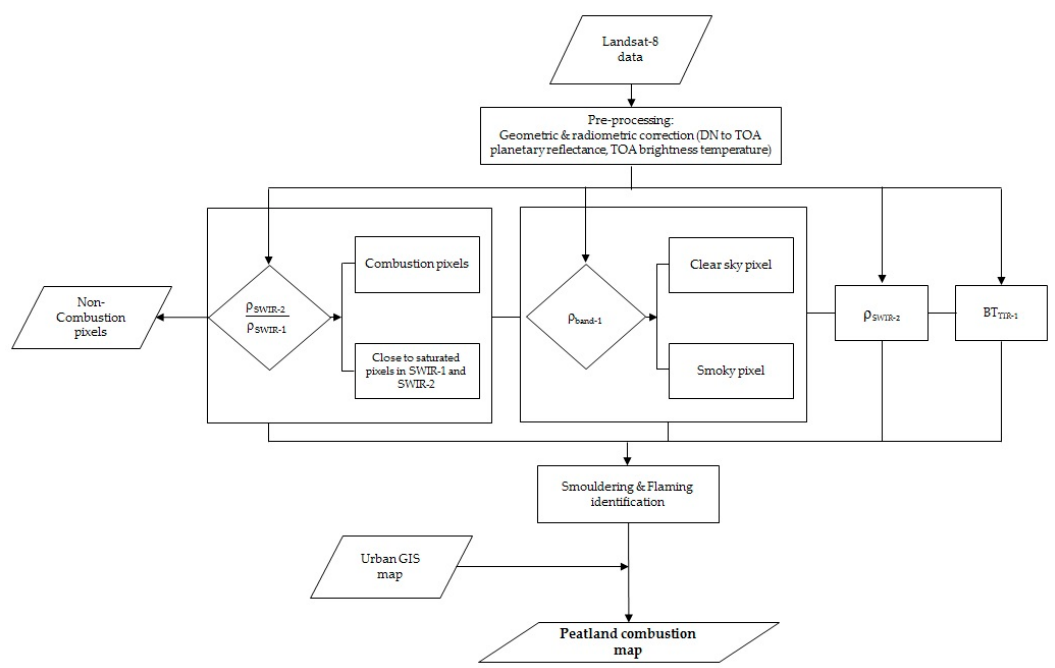
Figure 4. Flowchart of Landsat-8 image processing for mapping tropical peatland Figure 4 . Flowchart of Landsat-8 image processing for mapping tropical peatland combustion.